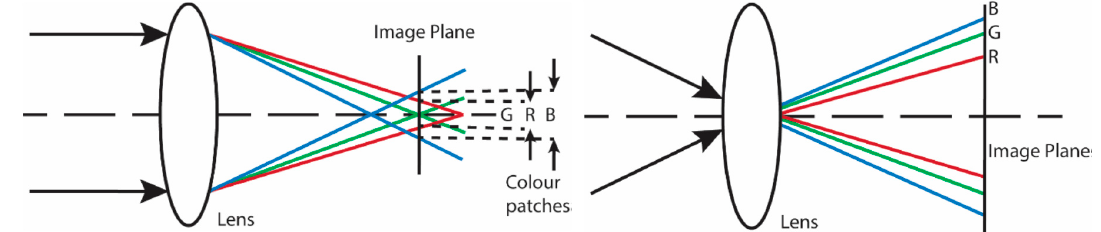
Figure 1. Longitudinal ( left ) and lateral ( right ) chromatic aberrations. Figure taken from [11].